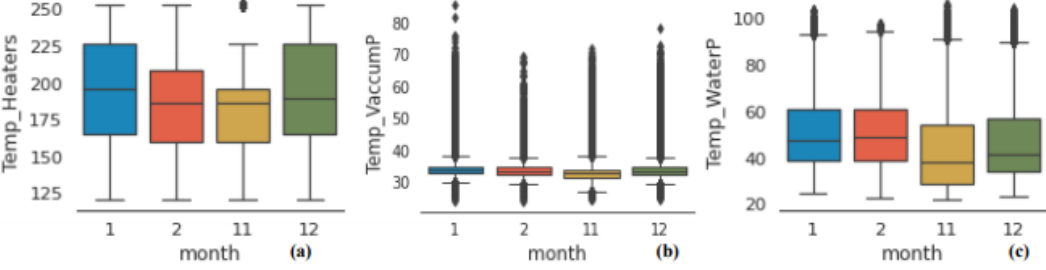
Figure 12. Distribution of collected data. ( a ) represents the data from steam generator, ( b , c ) represent the data from two different